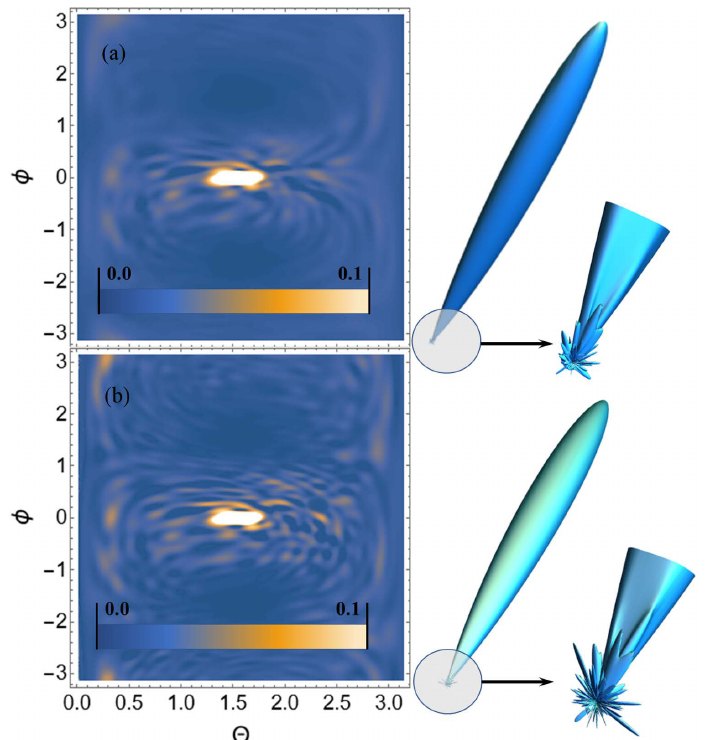
Figure 8. USP scattering spectra on the CGG trinucleotide: ( a ) calculated using Equation (4), ( b ) cal- culated by Equation (1). The spectra are presented as 2D ( left ) and 3D ( right ) plots. The 2D plots are presented in dimensionless units and normalised to the maximum value of the spectrum. The angles φ , θ are spherical angles in the coordinate system shown in Figure